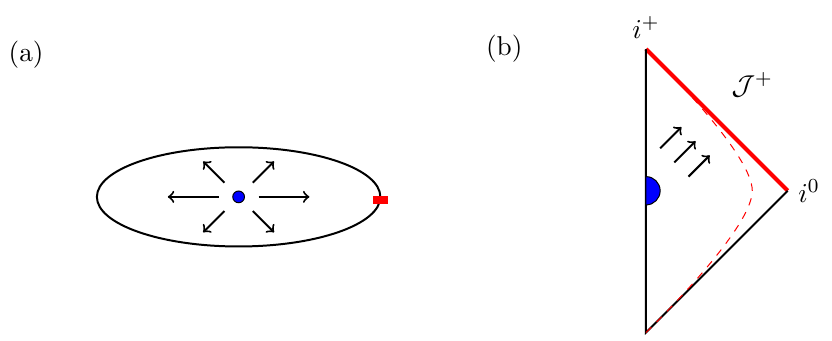
Figure 1 . In the conformal collider experiment (a), the energy created by a localized excitation (blue) is measured far away by a calorimeter (red). (b) For a CFT, this is equivalent to measuring + the energy at null infinity J